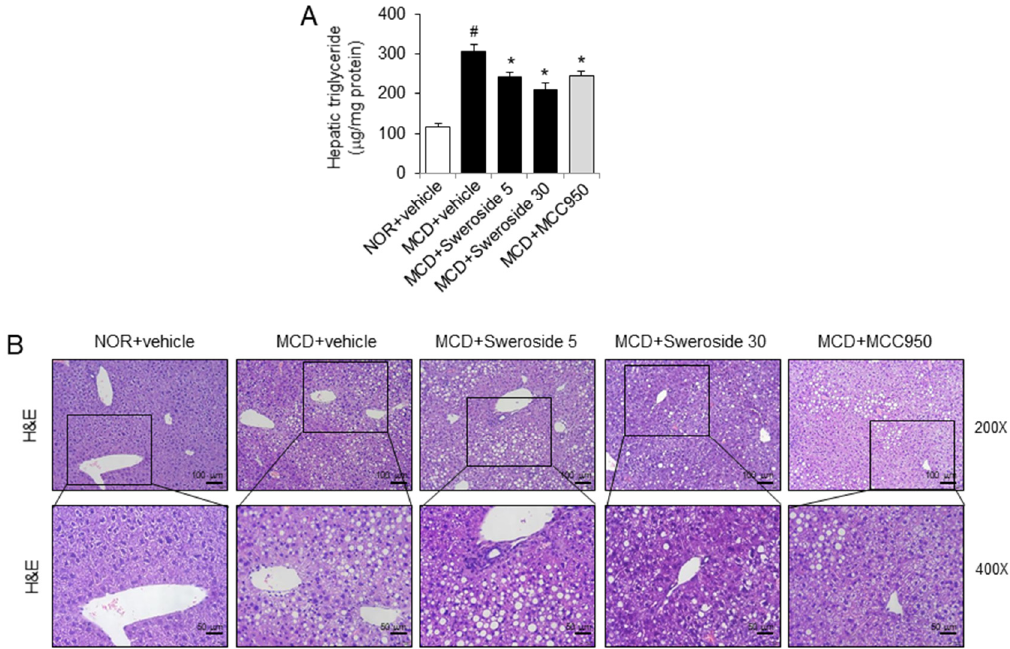
Figure 4. Sweroside reduces hepatic triglyceride accumulation in mice fed an MCD diet. Samples were obtained from the mice described in Figure 3. ( A ) Hepatic triglyceride levels. The values represent means ± SEM ( n = 8). #, significantly different from NOR + vehicle, p < 0.05. *, significantly different from MCD + vehicle, p < 0.05. ( B ) Representative H&E-stained sections of liver tissue (200 × and 400 × ). The hepatic steatosis and infiltrated neutrophils were identified via H&E staining. The purple dot indicates neutrophils.